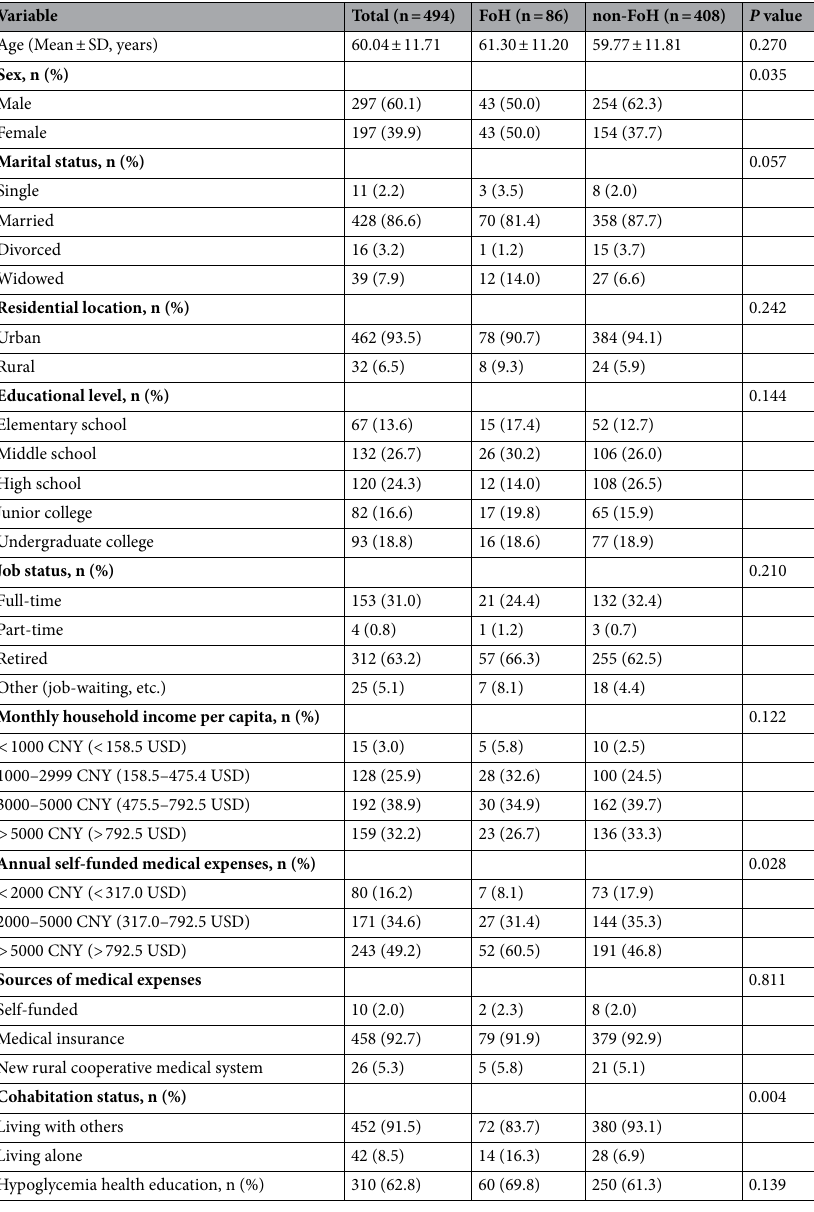
Table 1. Sociodemographic characteristics of patients with type 2 diabetes. FoH, fear of hypoglycemia; CNY, China Yuan; USD, US dollars; SD, standard deviation. The independent sample t-test, Pearson’s chi-squared test, and Fisher’s exact test were used to compare differences between